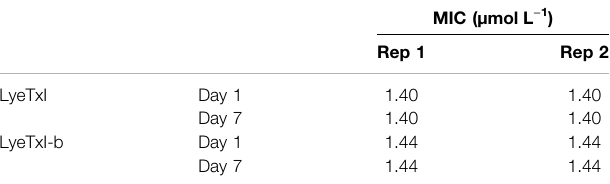
TABLE 6 | Minimum inhibitory concentration (MIC) values for LyeTxI and LyeTxI-b with increasing concentration in planktonic S. aureus